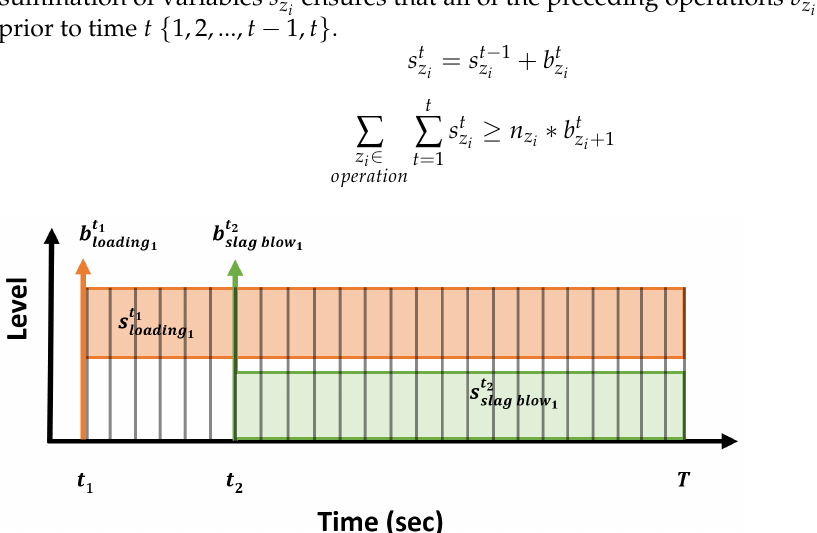
Figure 4. Precedence sequence